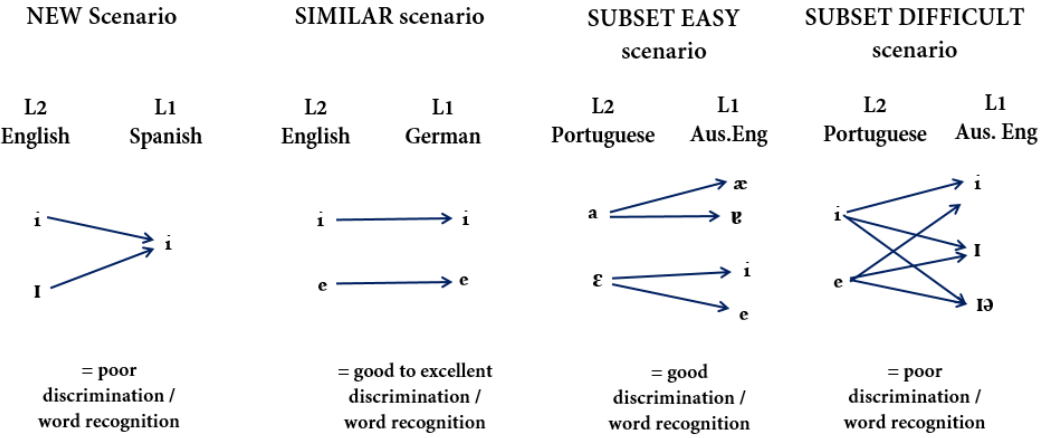
Figure 1. Visual representation of the L2LP learning scenarios.